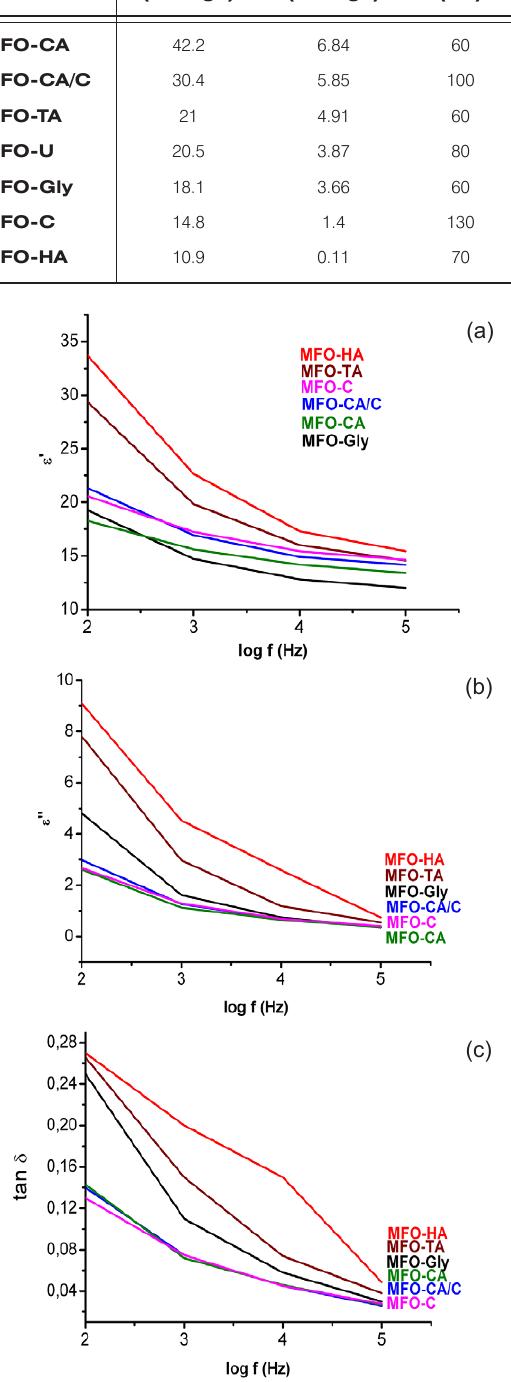
Table 6. Magnetic parameters measured and calculated at room temperature for MgFe